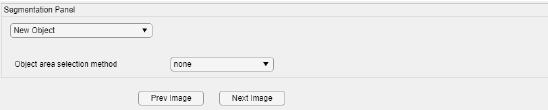
Figure 7. Segmentation panel.